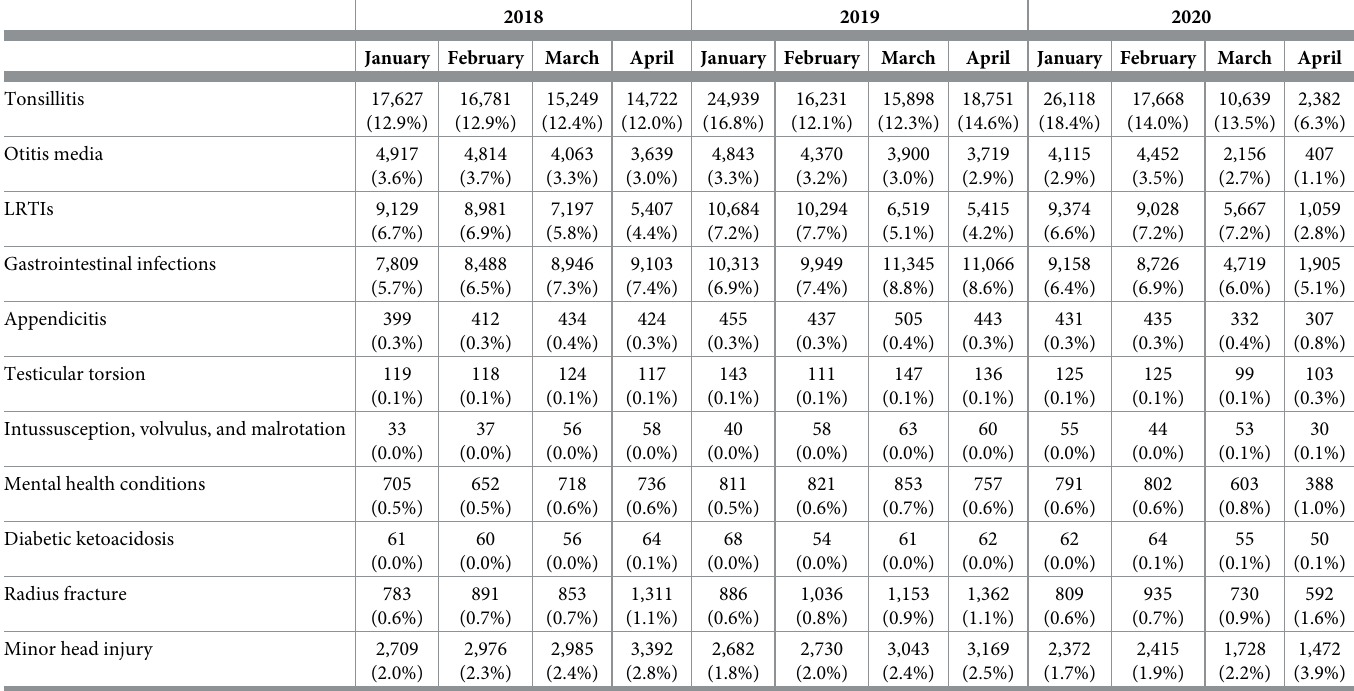
Table 3. Totals of selected clinical diagnoses in the ED for the period January–April over a 3-year